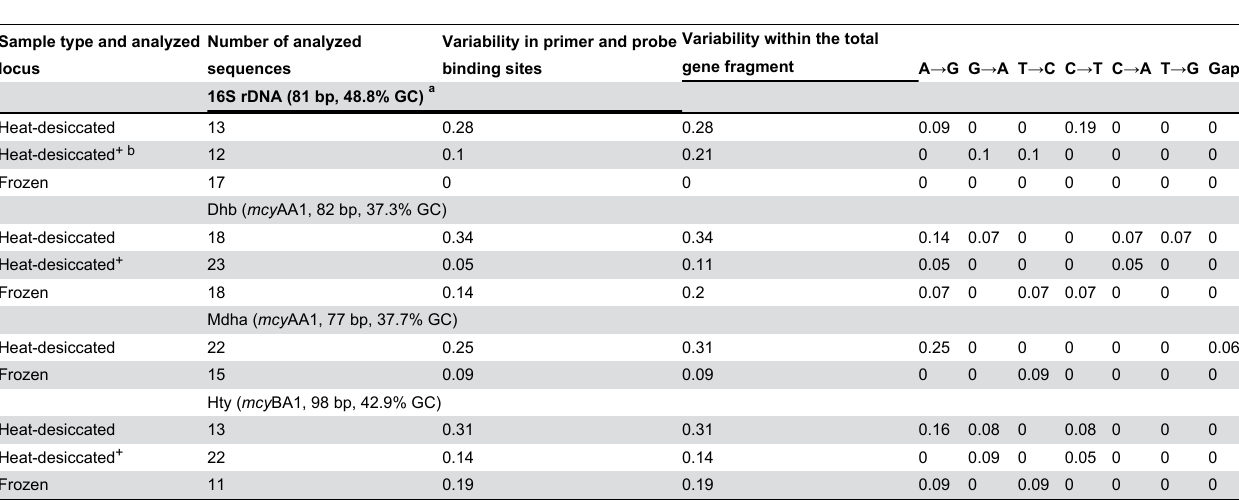
Table 1. Rate of nucleotide variability (per 100 bp) detected in DNA sequences obtained from heat-desiccated DNA (from 1980), an aliquot treated with the PreCR Mix, and DNA from frozen samples (from 2007).